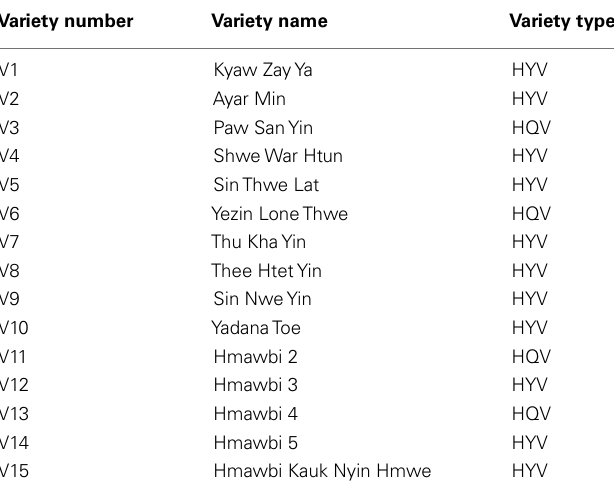
Table 1 | Myanmar rice varieties used in callus induction and regeneration